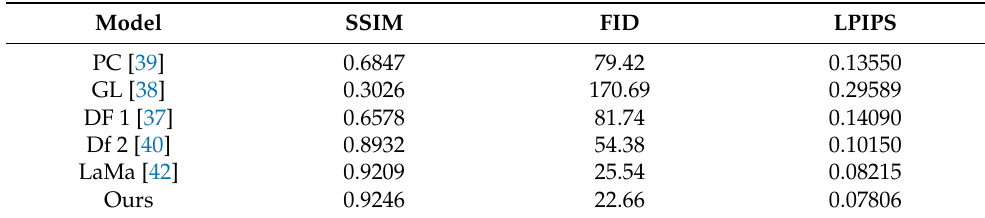
Table 1. Means of the quantitative comparison of the proposed method with already publicly available, robust baselines in FID, LPIPS, and SSIM metrics. The results of each model were derived from its public code.